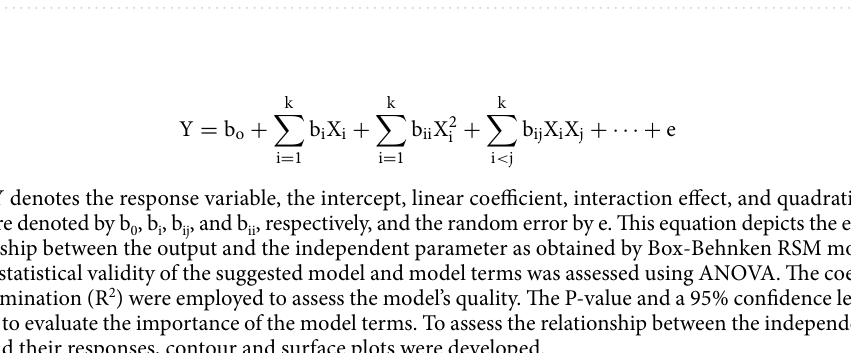
Table 2. The main physicochemical characteristics of sunflower